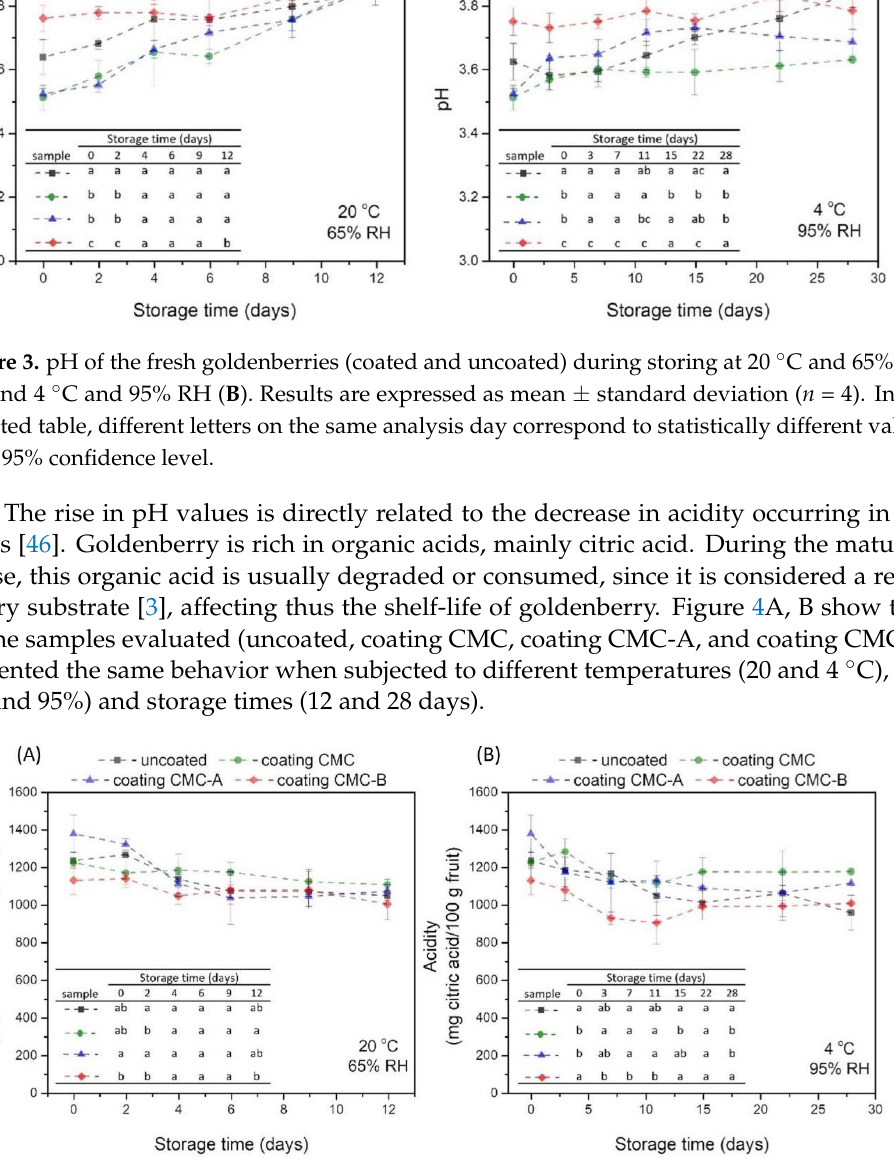
Figure 5. Total soluble solids of uncoated and coated fresh goldenberries as a function of storage time: ( A ) 20 °C and 65% RH and ( B ) 4 °C and 95% RH. Results are expressed as mean ± standard deviation ( n = 6). In the inserted table, different letters on the same analysis day correspond to sta- tistically different values for a 95% confidence level. Usually, total soluble solids rise during fruit ripening due to the gradual degradation of starch and cell wall materials [3], resulting in an increase in the sugar content. On the